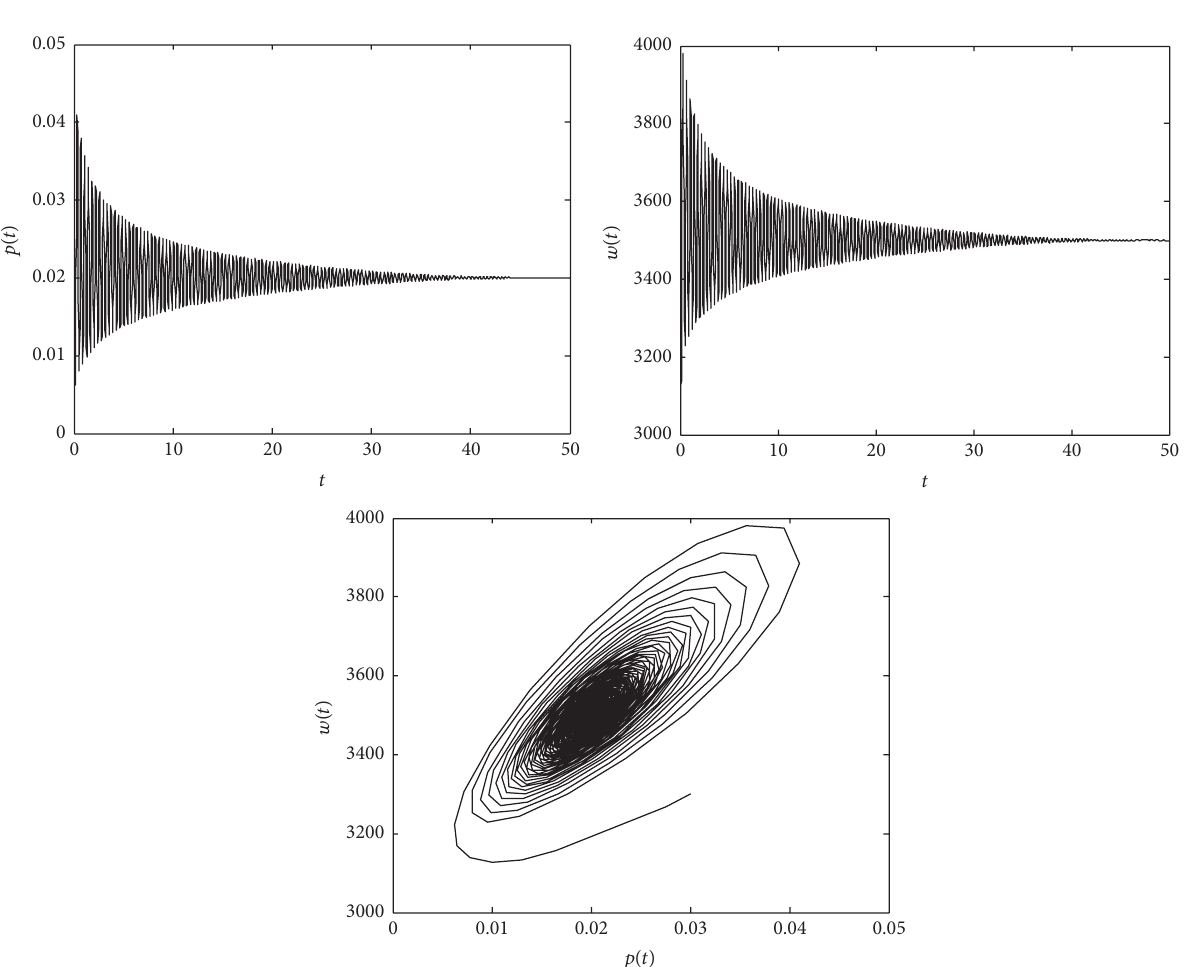
Figure 6: State plot and phase plot of time-delay feedback controlled system (6) with 𝛼 = 1000 and 𝑎 = 0.8